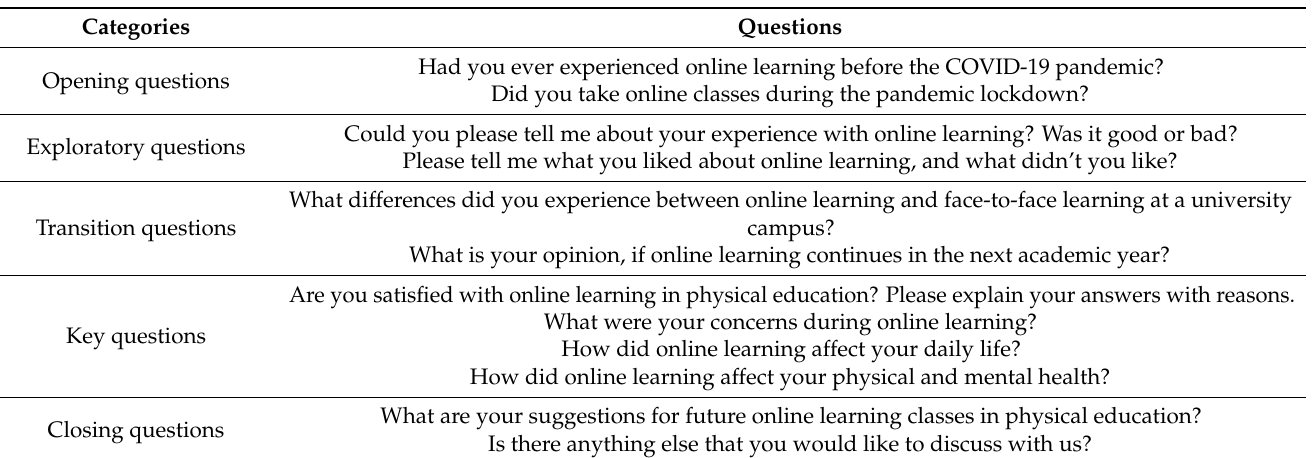
Table 2. Questions for focus group